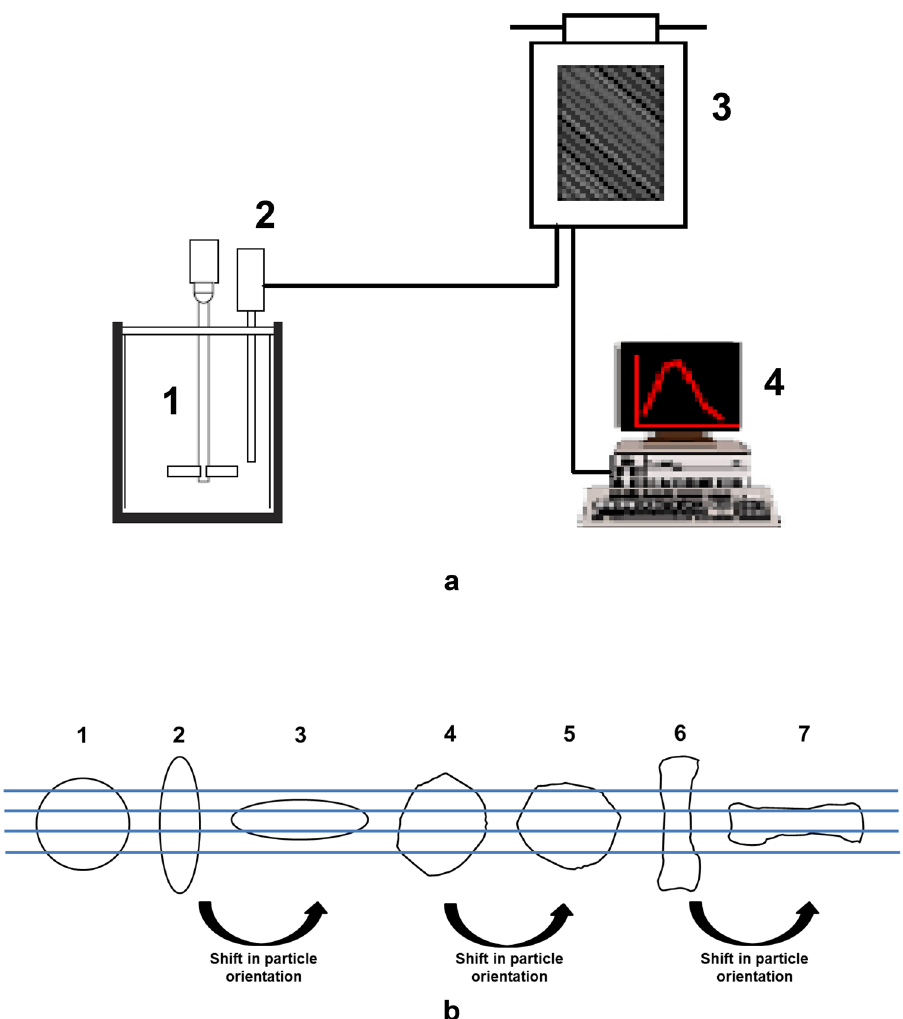
Figure 6. Schematic drawing of probe positioning relative to the impeller (1. Propeller stirrer; 2. FBRM probe; 3. Processing unit; 4. PC monitoring the particle size distribution on-line) ( a ), and Examples of the measured chord length (line) when a laser beam crosses (1) a spherical particle, (2 and 3) an oval particle in different positions and (4, 5, 6 and 7) an irregular particle in different positions—illustration of the effect of particle orientation on the obtained chord length ( b